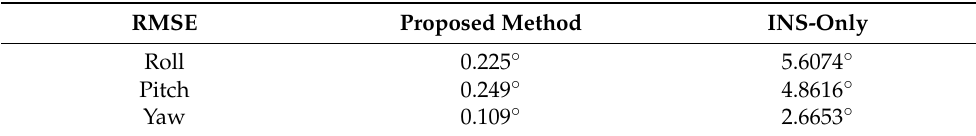
Figure 13. Comparison of attitude results. Table 4. Comparison of attitude estimation performance.